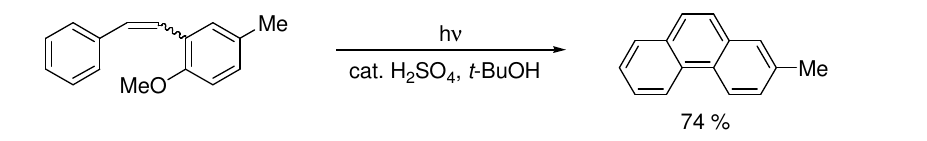
Table 2. Comparison of product formation between oxidative and basic elimination conditions [31].